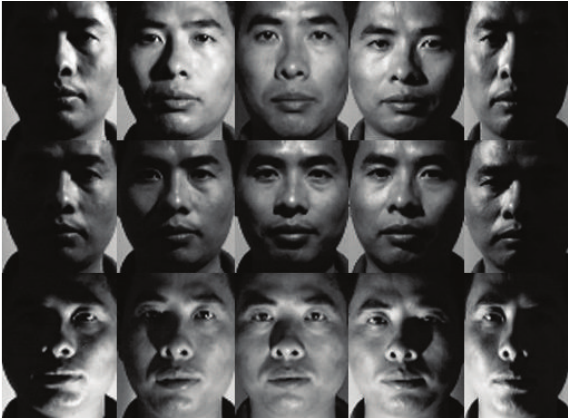
Figure 11: Normalized facial images from CAS-PEAL face